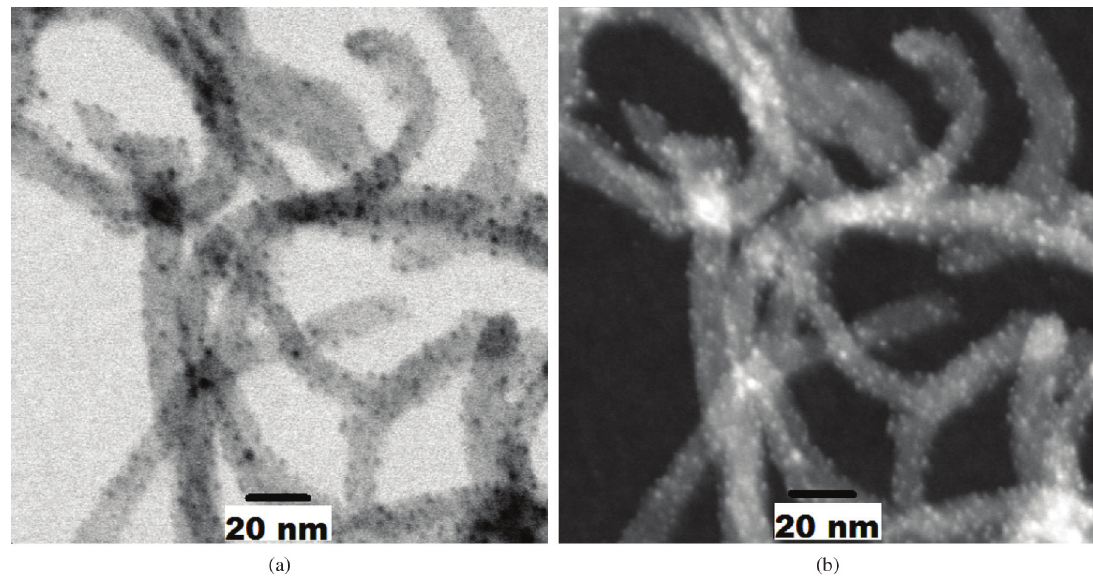
Figure 3. STEM images of Ag decorated MWCNT-F. 3A shows a STEM bright field image (using transmitted electrons) showing dark Ag nano-particles homogeneously dispersed onto the MWCNT surface. 3B shows the same image in STEM dark field mode, formed by diffracted electrons, where the diffracted electrons collected from Ag particles are bright.